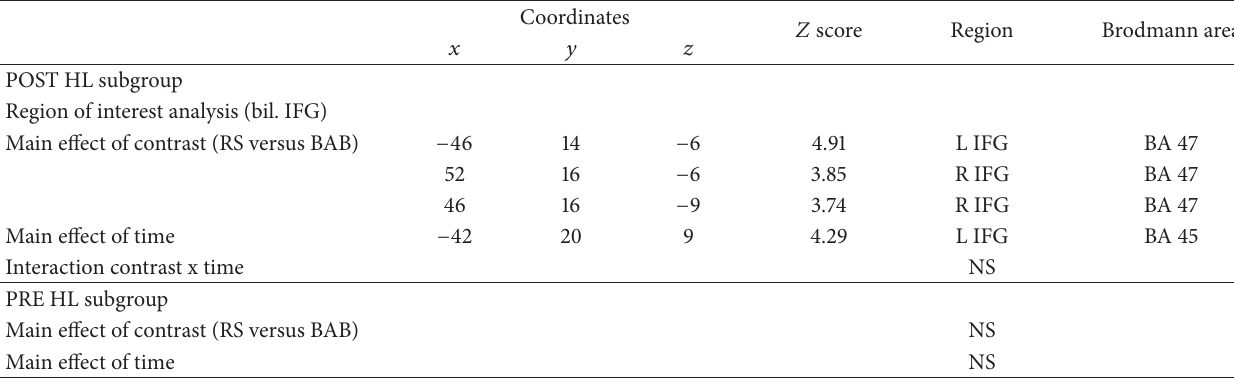
Table 4: Main effects and interactions of analysis 3 performed across CI- and NH-participants at baseline on the whole brain (top) and on a region-of-interest based on main effect of contrast (bottom).